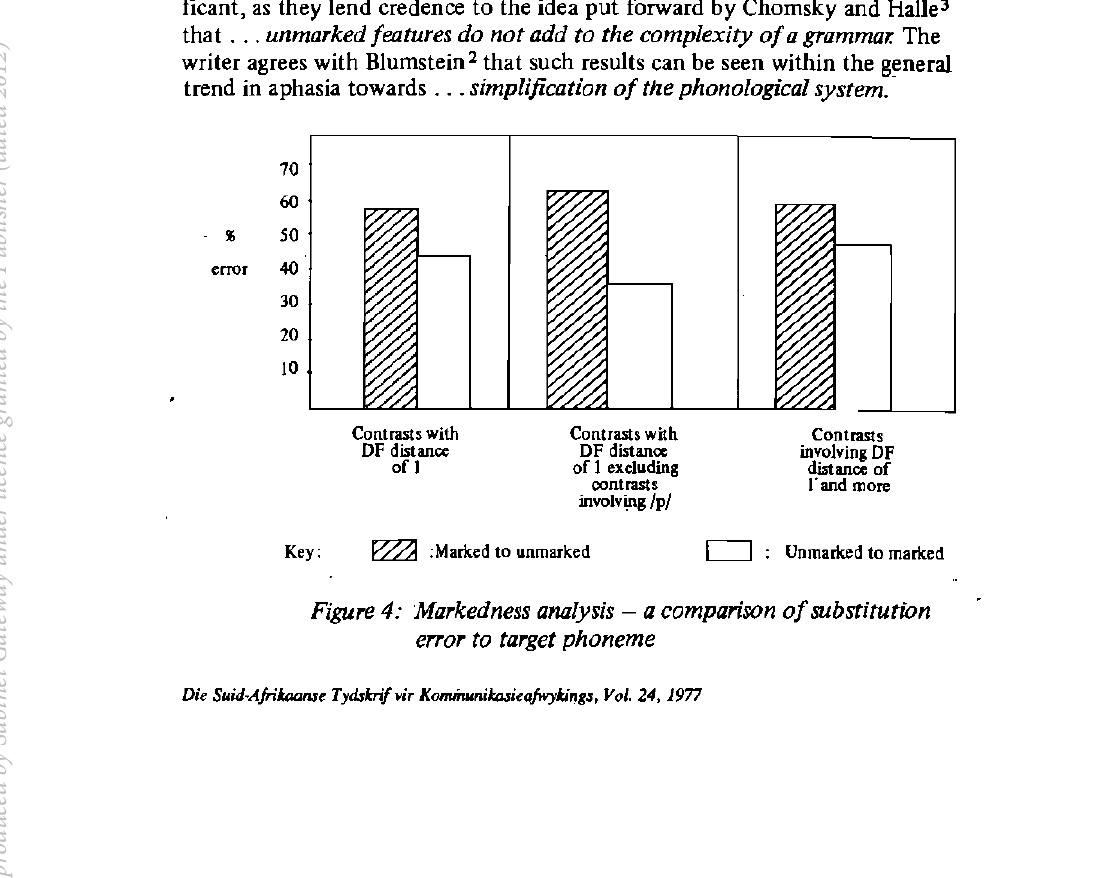
Figure 3: Anterior ^compared to back substitution errors.